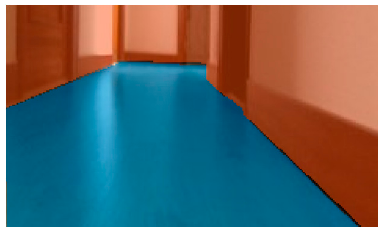
Figure 4. An example of the labeled image from data acquisition.